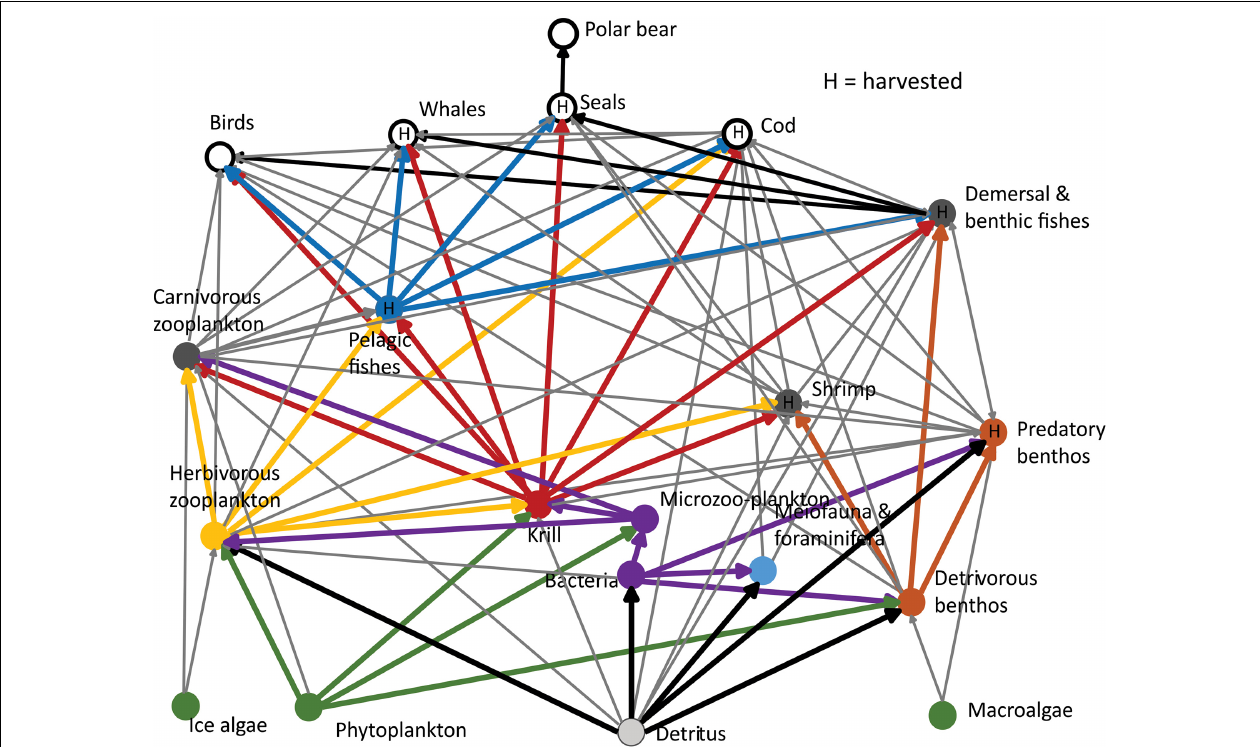
FIGURE 4 | Carbon flows between aggregated major compartments based on the Ecopath model for year 2000 with four major pathways for carbon flows from lower to higher trophic levels. (i) the microbial food-web pathway (violet lines), (ii) the copepod pathway (yellow lines), (iii) the krill pathway (red lines), and (iv) the benthic invertebrate pathway (brown lines). Functional group outputs are aggregated according to Table 1 . Thick lines shows major flows, i.e., among the three largest flows to each aggregated compartment. Thin lines shows smaller flows. “H” in circles indicate harvested compartments.